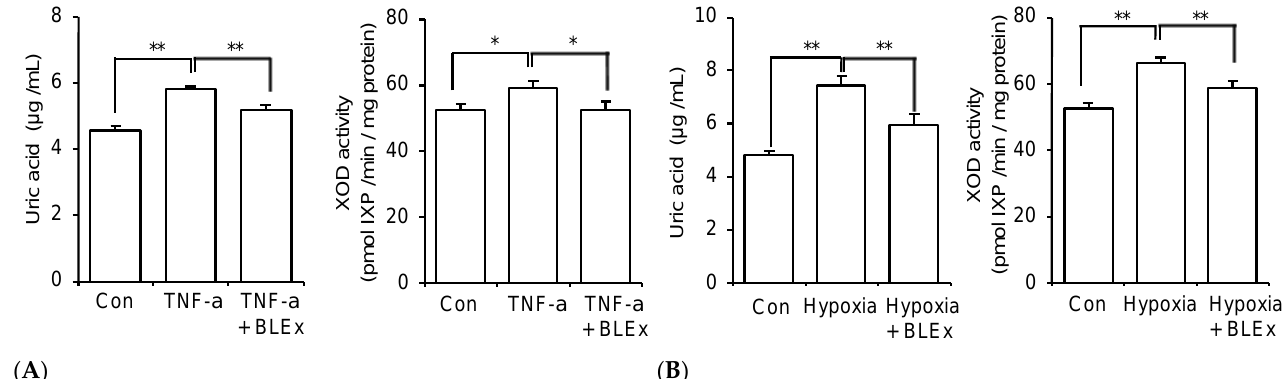
Figure 7. Effect of BLEx on uric acid production by 3T3-L1 adipocytes under TNF- α stimulation and hypoxic stress. Data